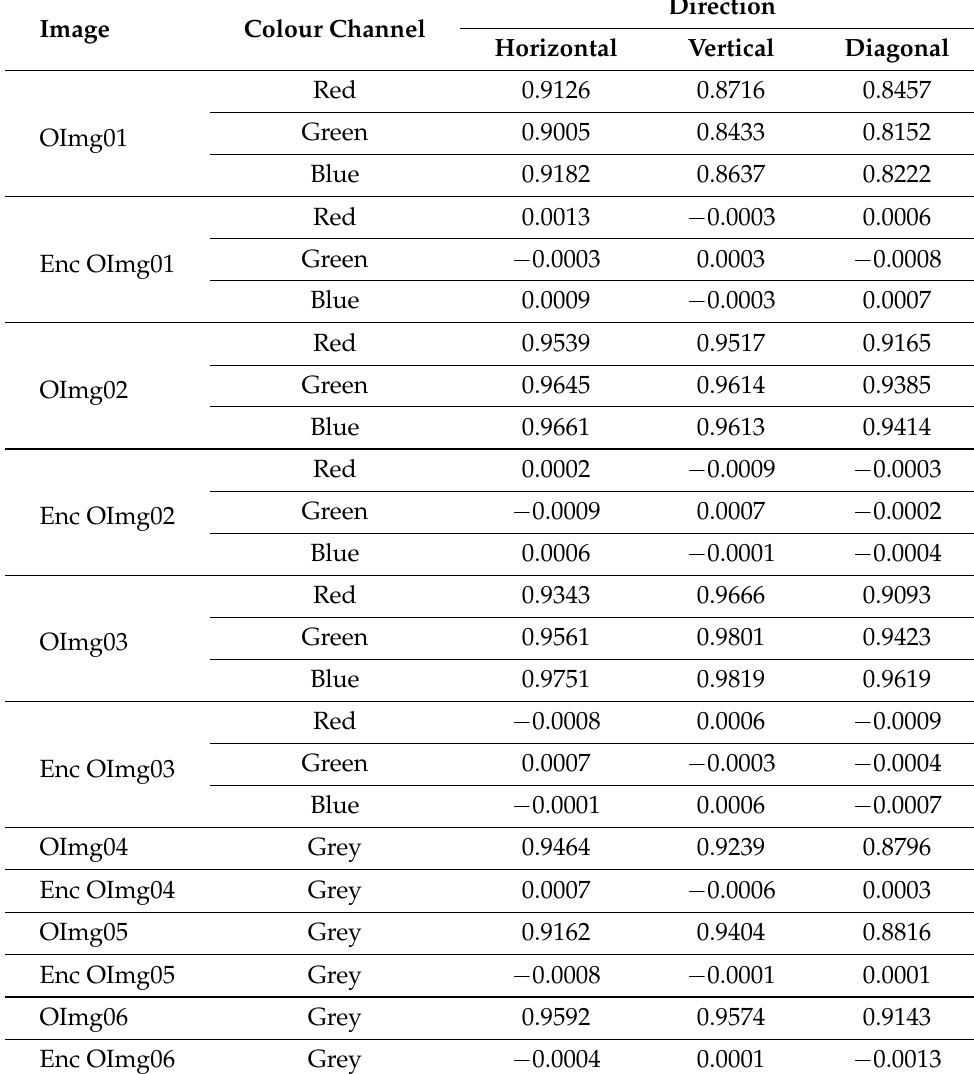
Table 4. Correlation coefficients for pristine images and their encrypted ones before embedding onto a reference